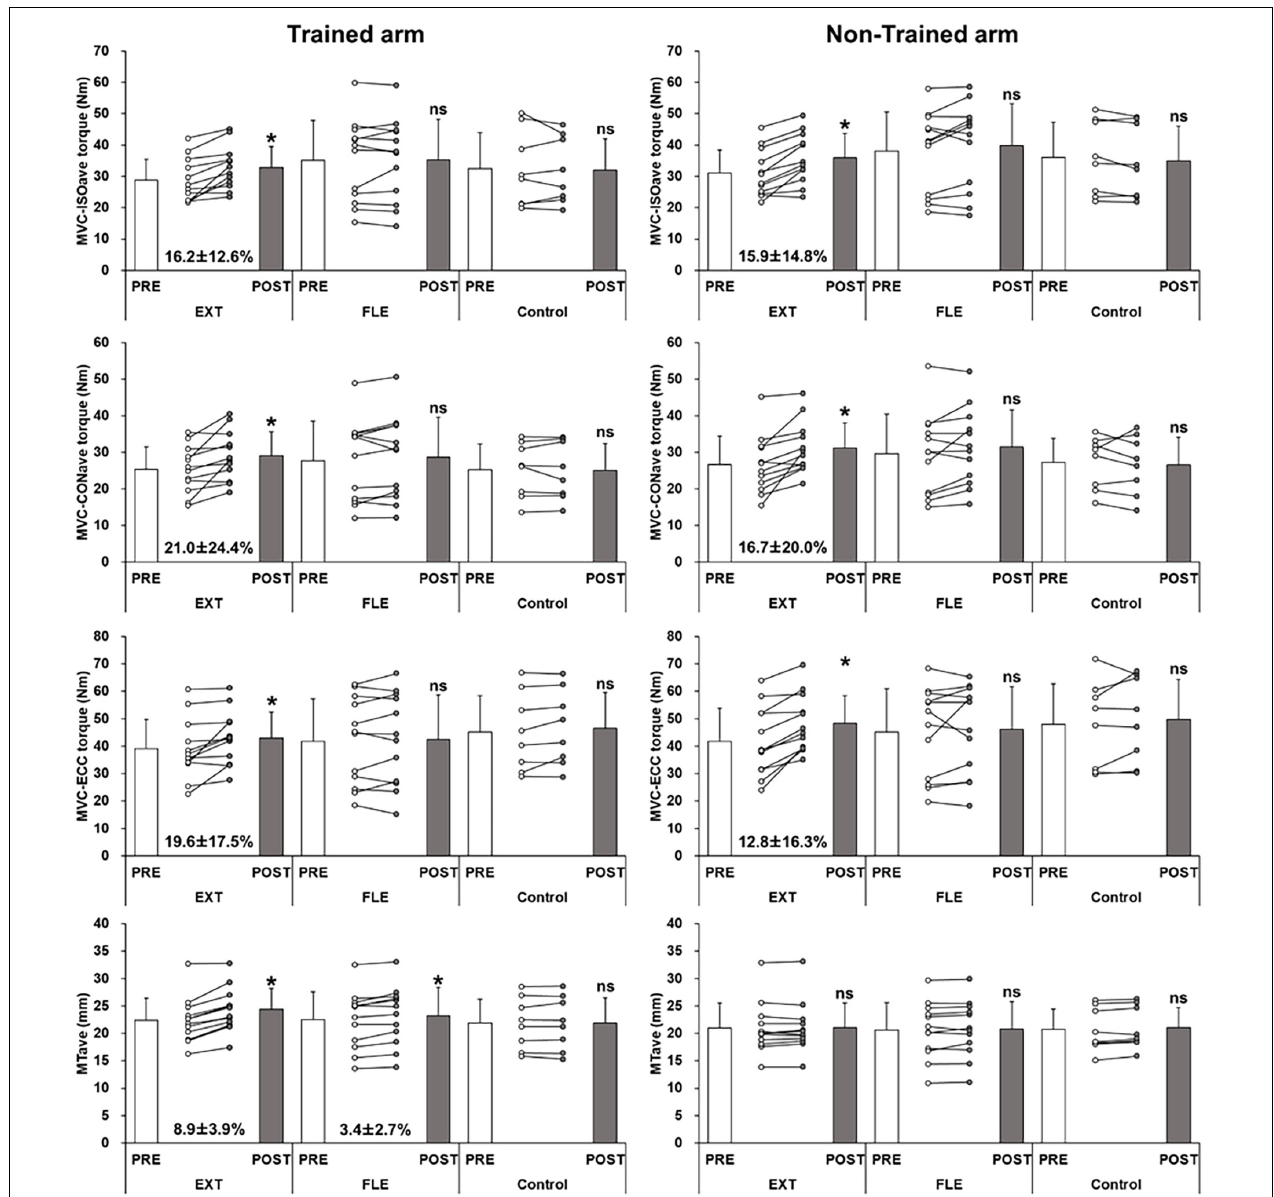
FIGURE 1 | Changes (mean ± SD, individuals) in average maximum voluntary isometric contraction torque of four different angles (MVC-ISO ave ), concentric contraction torque at two different velocities (MVC-CON ave ), eccentric contraction (MVC-ECC) torque, and muscle thickness at three positions (MT ave ) before (PRE) and after (POST) 5-week training at more extended elbow joint angles (EXT) or more flexed elbow joint angles (FLE), and for the control group without training in trained arm. *: significant ( p < 0.05) difference from the PRE-value, ns: no significant difference from the PRE-value.